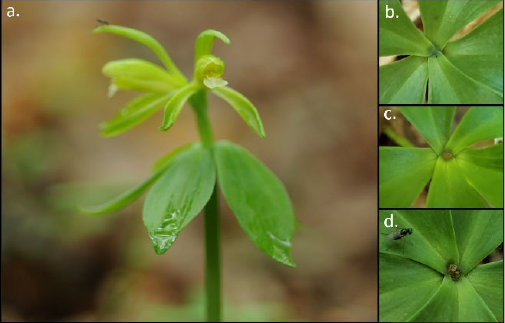
Figure 1. Flowering plant of Isotria medeoloides . ( a ) Leaves, typically 5, are in a whorl at the top of the stem, which emerges in the spring. Most reproductive plants produce one flower but two flowers per plant are not uncommon and, at times, plants with three flowers have been seen. Flowering that does not produce fruit can still be assessed by comparing the scars in the center of the leaf whorl to determine if the plant had 0 ( b ), 1 ( c ), or 2 ( d ) flowers.